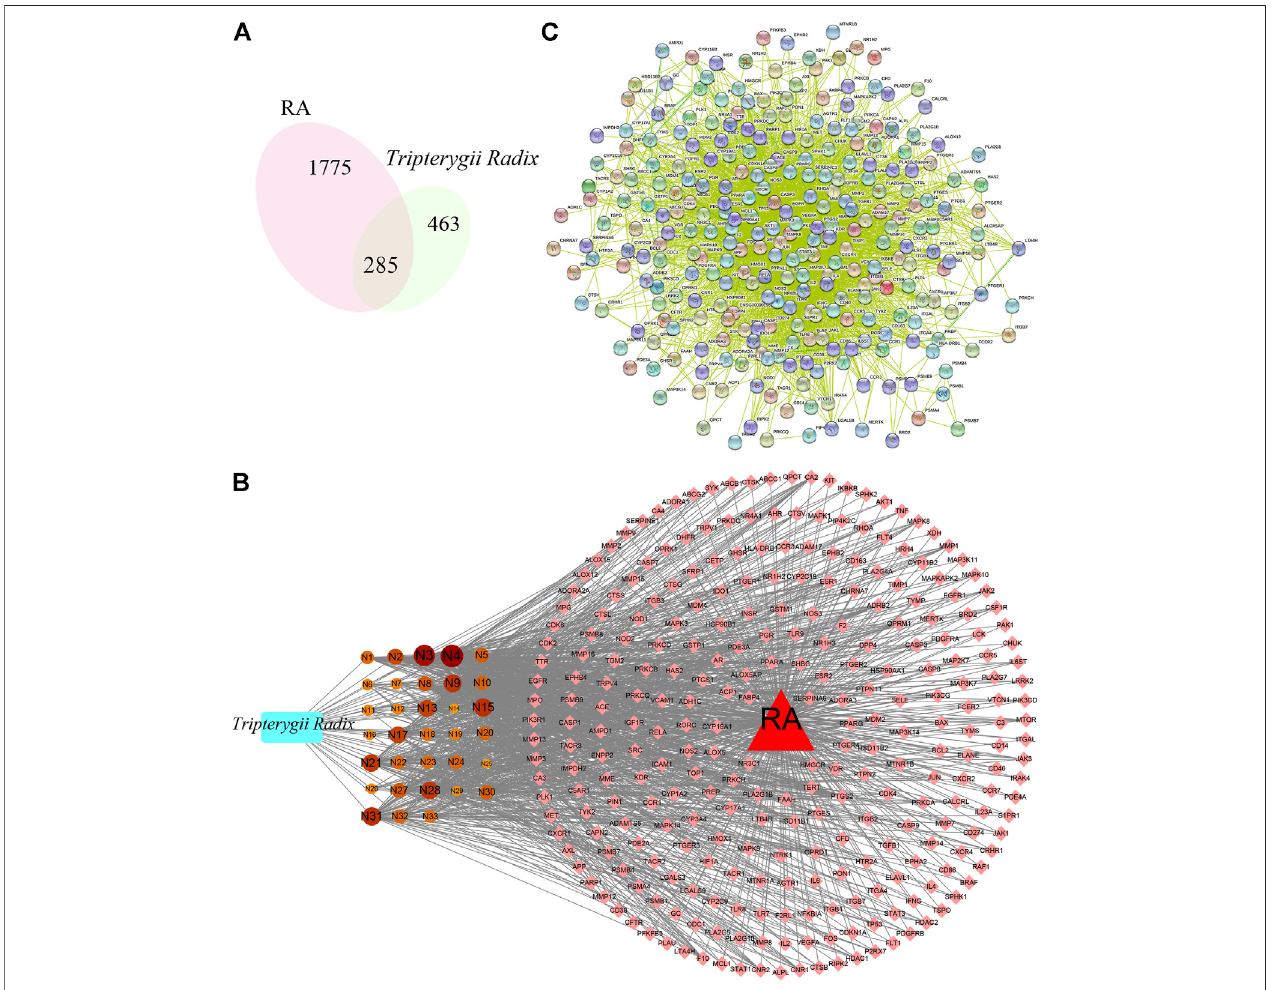
FIGURE 2 | (A) represents the venn digram of biotargets between Tripterygii Radix and RA, While (B) represents the drug-active components-biotargets-disease network of Tripterygii Radix against RA. The rectangle represents Tripterygii Radix, the circle nodes represent active components, the diamond nodes represent biotargets, and the triangle represent RA. The 33 components nodes changed with the degree value. The higher the degree value, the bigger was the node. (C) represents the PPI network of the common biotargets.